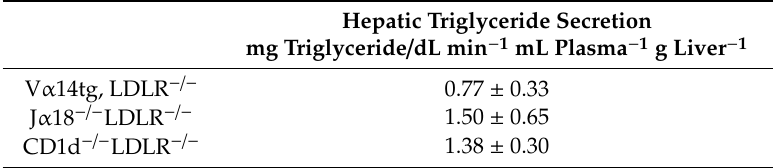
Table 2. Hepatic triglyceride secretion. Female mice fed WTD for 12 weeks were fasted 4 h and injected with Triton WR1339 and plasma triglyceride levels in the plasma monitored over 3 h. n = 3–5 per